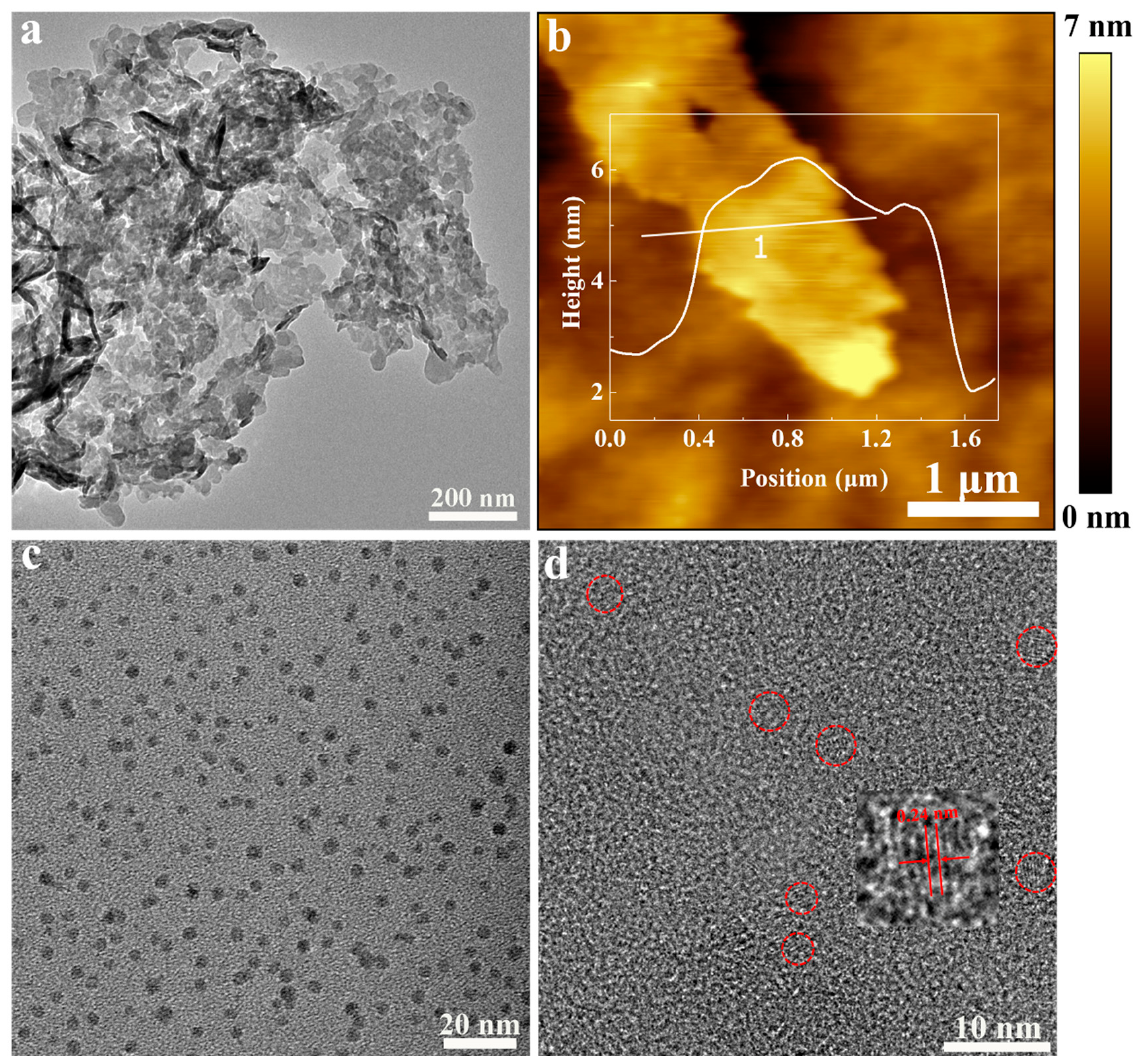
Figure 1. ( a ) TEM image of CNs; ( b ) The atomic force microscope image of CNs, and the white inset is the corresponding height profile along the white line; ( c ) TEM image of GQDs; and ( d ) High resolution transmission electron microscope (HRTEM) image of CNs/GQDs-3. The red circle and the inset are the location and magnification of GQDs, respectively.